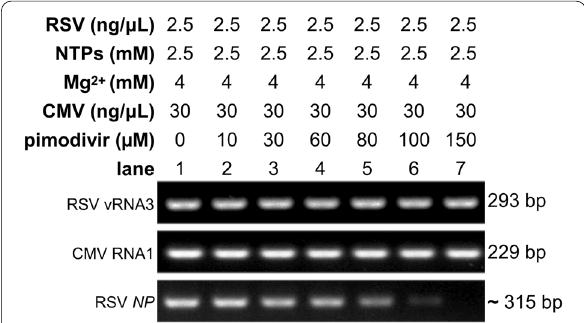
Fig. 4 The effect of pimodivir on the transcription of RSV. The chimeric RSV mRNA (RSV NP ) produced in vitro from each reaction with a mixture as indicated on top of the gel was amplified by nested RT-PCR. Similar nested RT-PCR was conducted to detect RSV and CMV genomic RNAs. The RT-PCR product was electrophoresed in a 1.5% agarose gel before being visualized